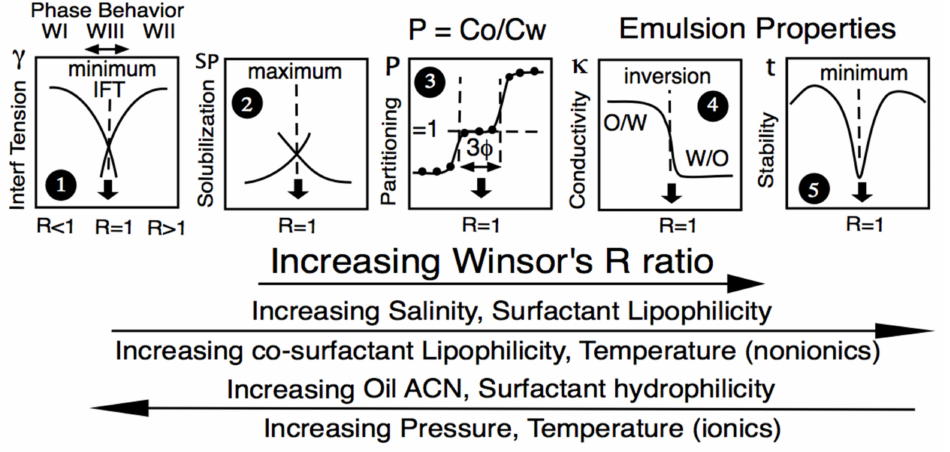
Figure 3. Variation of some SOW equilibrium or emulsified properties along a formulation scan, with R increasing from left to right according to the variable changes indicated below in the direction of the